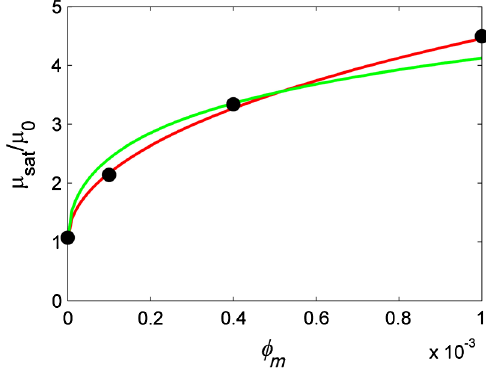
FIG. 8. Measurement ( (cid:5) ) of the saturated mobility (cid:1) sat at ¼ 2 V normalized to the equilibrium mobility (cid:1) V dc 0 V , as a function of the surfactant concentration (cid:2) line shows the expectancy from the standard theory, (cid:1) sat =(cid:1) 0 ¼ ½ 1 þ (cid:3) ð (cid:1) n Þ R (cid:3) =f ½ (cid:3) ð (cid:1) n Þ R (cid:3) , using the relations (cid:1) n ¼ 2000 (cid:2) (cid:1) m (cid:1) 3 and R ¼ 3 : 38 (cid:1) m . For the green line, the retardation (cid:2) m force is reduced with a correction factor (cid:7) ¼ 0 : 9 while using the concentrations (cid:1) n ¼ 5300 (cid:2) (cid:2) m (cid:1) m (cid:1) 3 obtained from current measurements and R ¼ 3 : 38 (cid:1) m